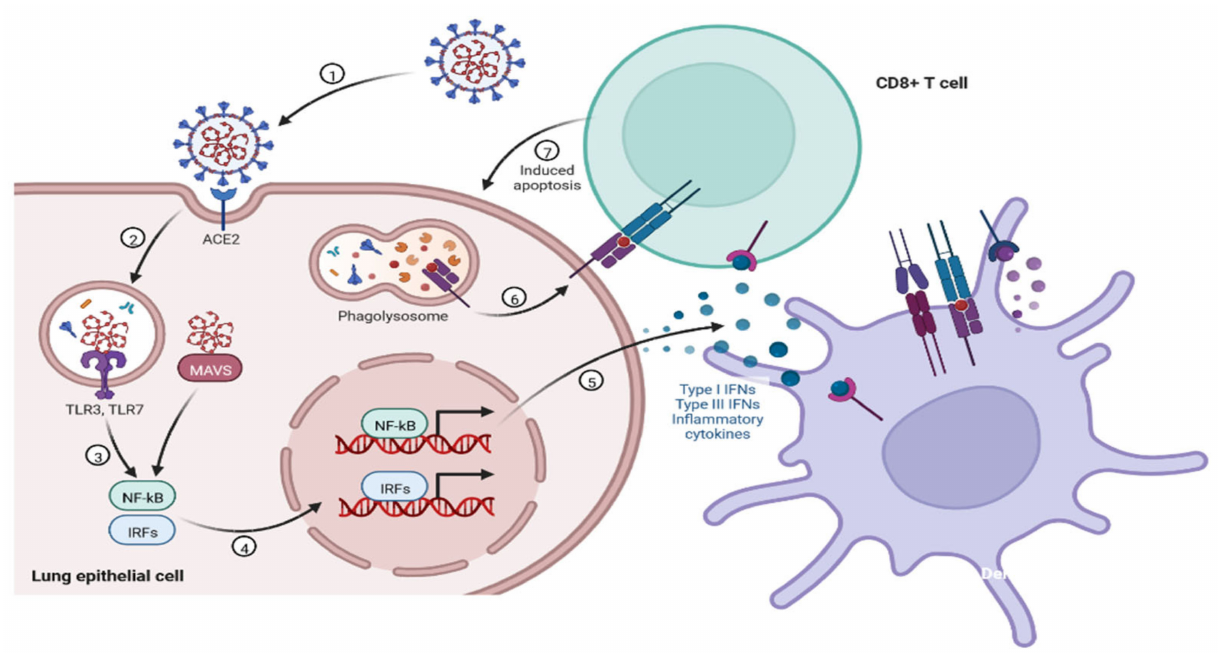
Figure 5. Coronaviruses are RNA viruses, some of which can infect human lung epithelium via the receptor ACE2. Viral RNA activates the endosomal and cytoplasmic sensors, TLR3/7 and MAVS, respectively. These receptors activate Interferon Regulatory Factors (IRFs) and NFkB to induce inflammatory cytokines, including interferons (IFN). Dendritic cells (DCs) sample antigen and migrate to lymphoid organs to prime adaptive immunity. CD8 T cells induce apoptosis after recognition of antigen on DCs or infected